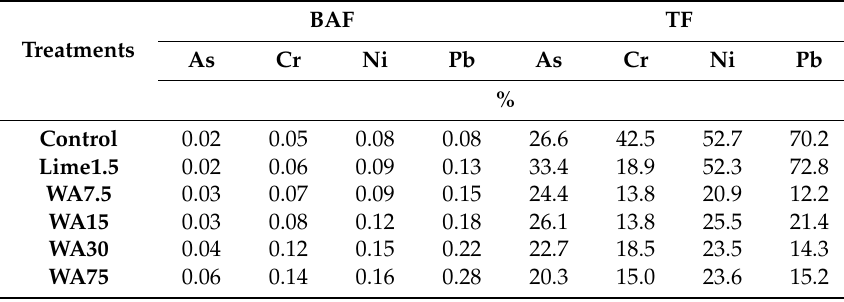
Table 5. Bioaccumulation factor (BAF) and translocation factor (TF) for heavy metal(oid)s in ryegrass ( Lolium perenne